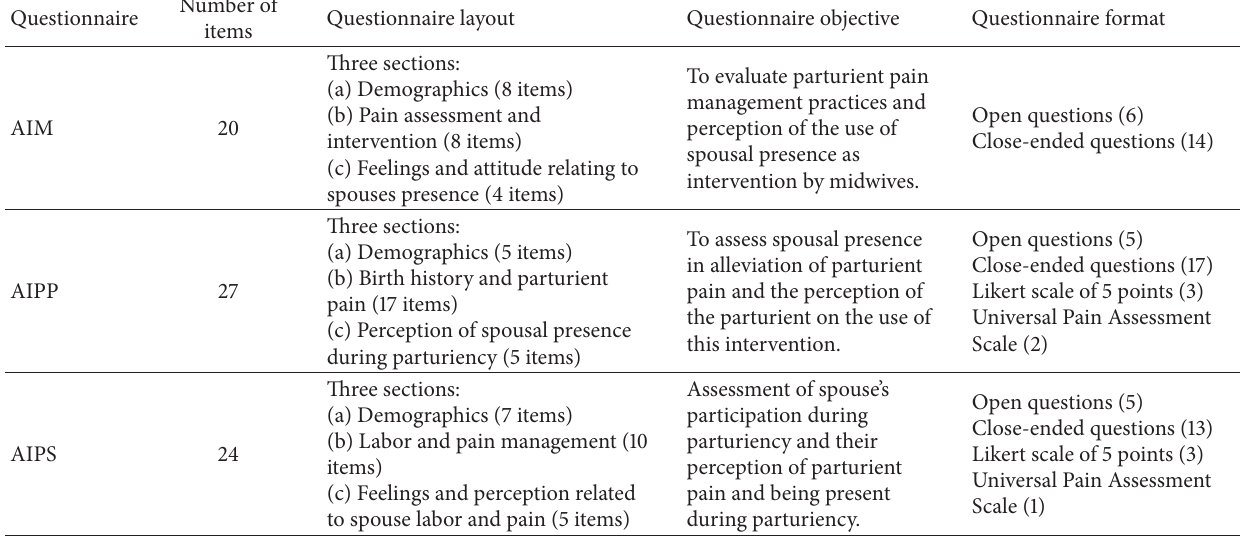
Table 1: Description of the questionnaires, Abuja Instrument for Midwives (AIM), Abuja Instrument for Parturient Pain (AIPP), and Abuja Instrument for Parturient Spouses